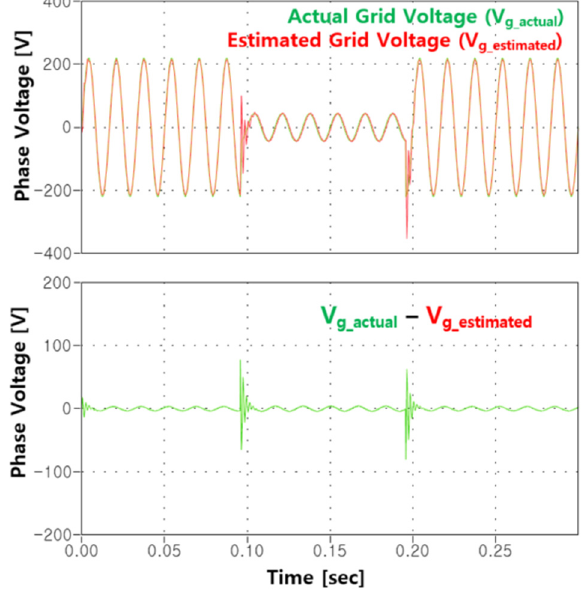
Figure 10. Simulation results of actual grid voltage and grid voltage using an observer.